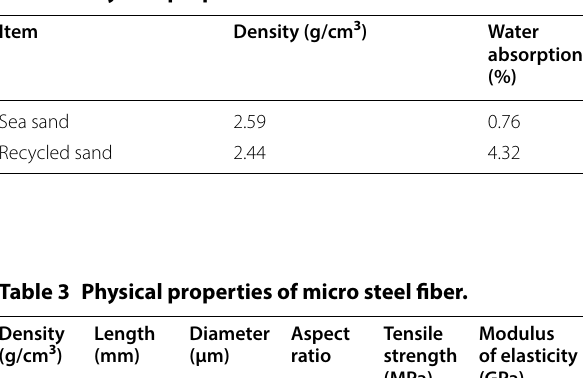
Table 2 Physical properties of sand.